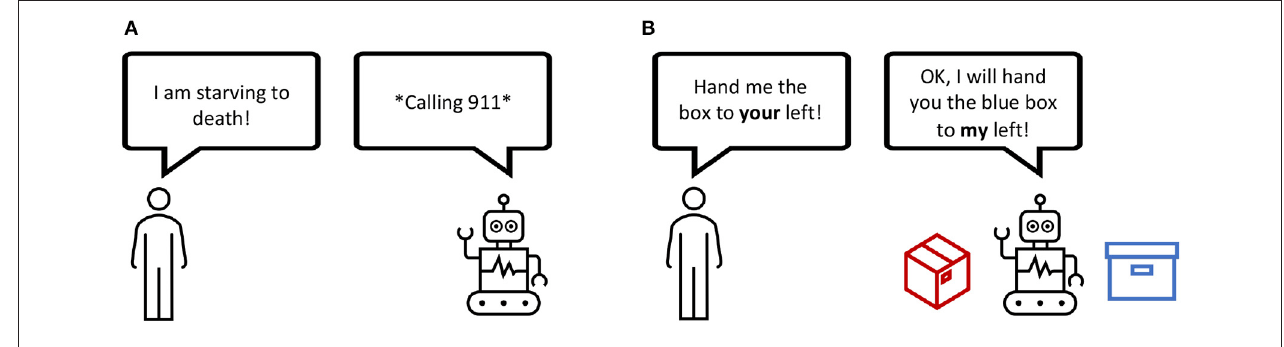
FIGURE 1 | (A) Misunderstanding a metaphor, potentially due to the lack of a self-representation. (B) A robot using the self as point of reference to understand an